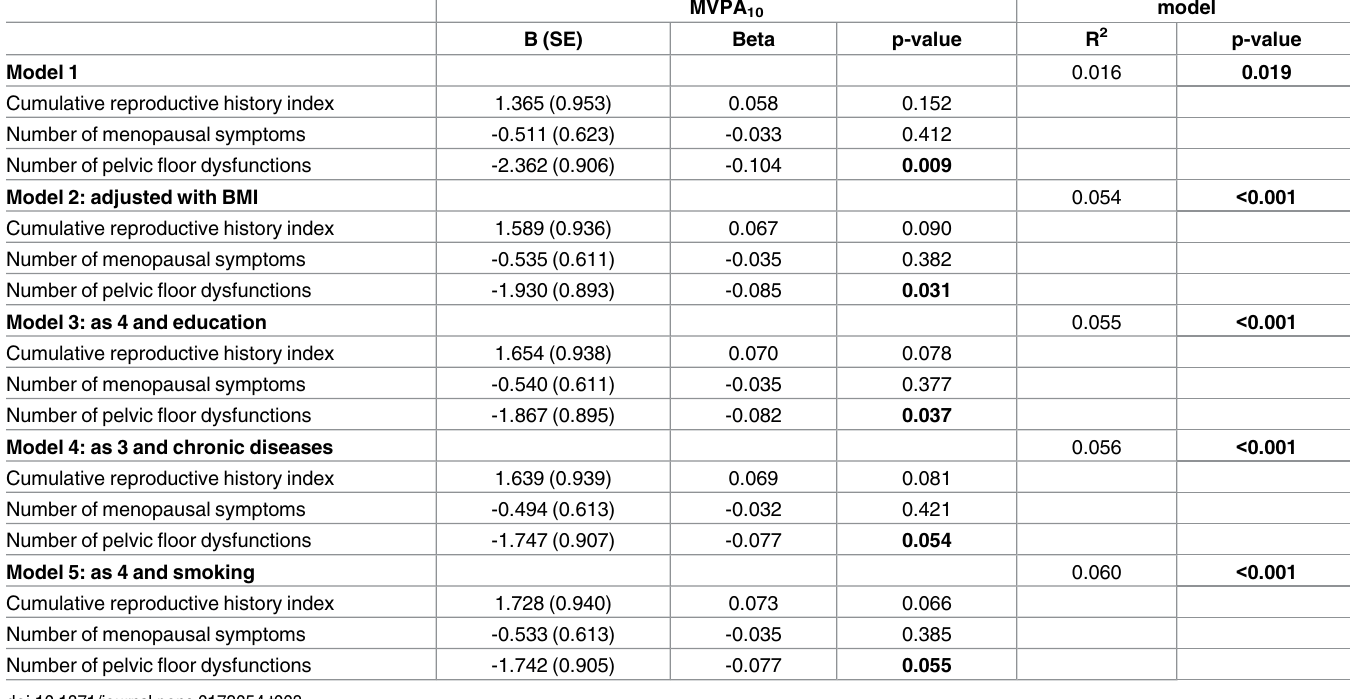
Table 3. Multiple linear regression analysis of at least 10-minute activity bouts performed at moderate to vigorous intensity (MVPA 10 ) as depen- dent variable.